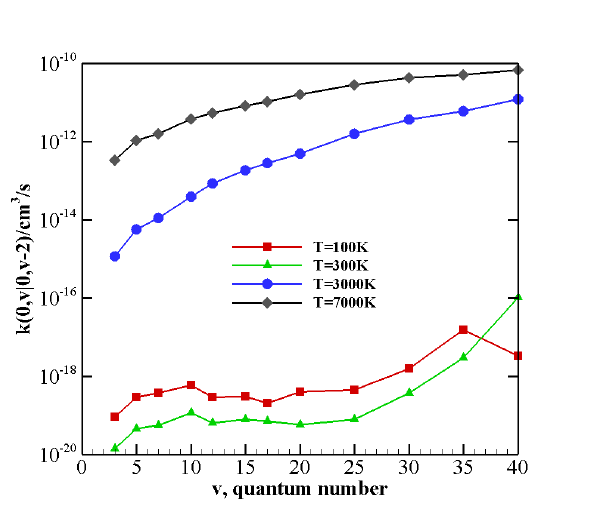
Figure 9. Multiquantum V–T/R rate coefficients as a function of the vibrational quantum number v at different temperature values for transitions ( upper panel ) CO ( v ) + N 2 ( 0 ) → CO ( v − 2 ) + N 2 ( 0 ) ;